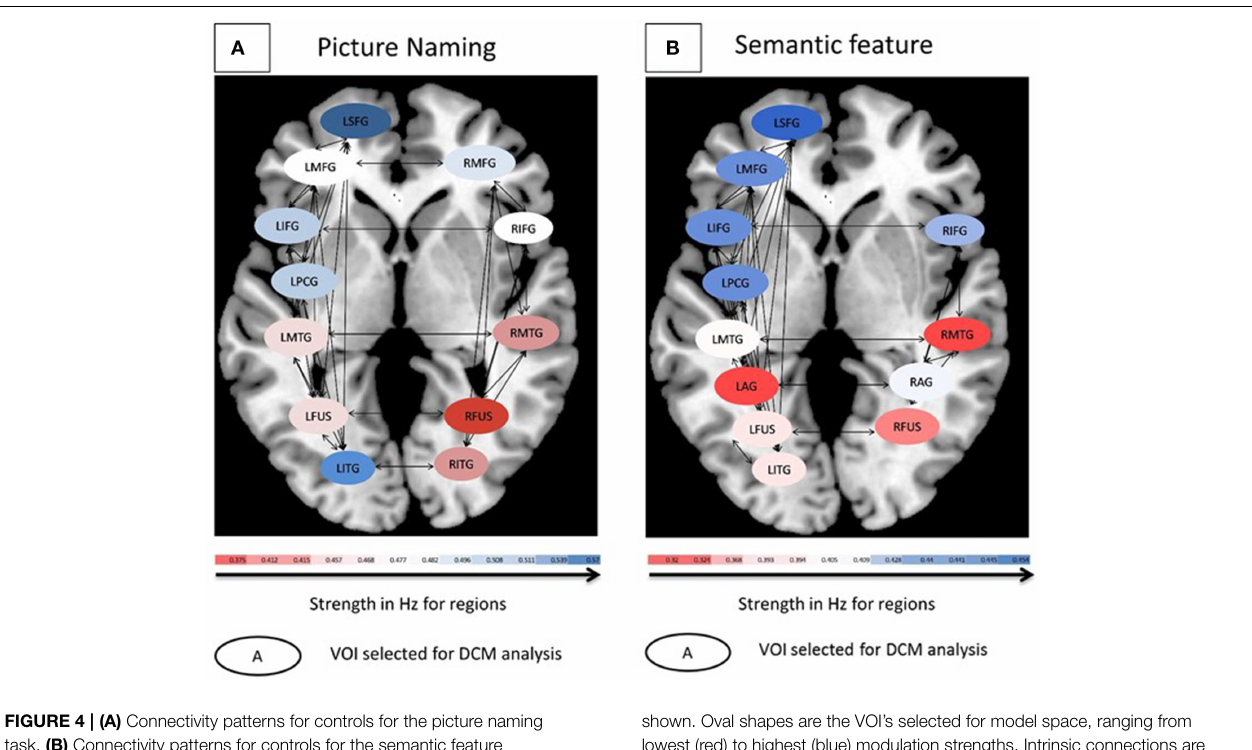
FIGURE 4 | (A) Connectivity patterns for controls for the picture naming task. (B) Connectivity patterns for controls for the semantic feature verification task. For both tasks, average modulation for eight controls are